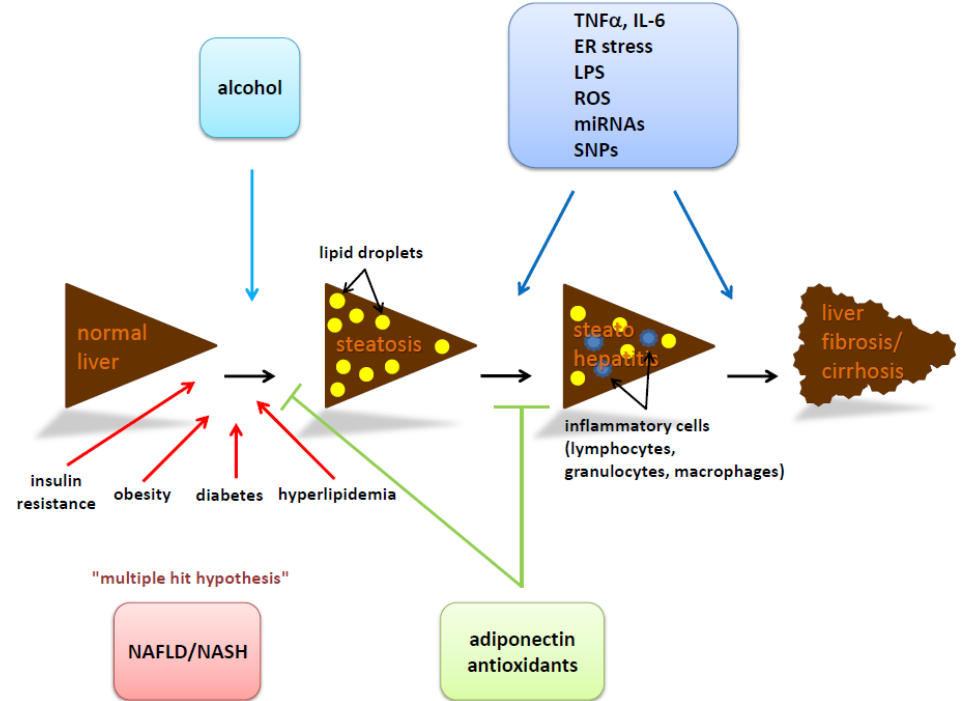
1. Schematic illustration of non-alcoholic fatty liver disease (NAFLD)/ non-alcoholic steatohepatitis (NASH) progression. A lifestyle with a balanced diet, moderate alcohol consumption and regular exercise supports the maintenance of an intact liver function. The intake of high energy food, less exercise and/or enhanced drinking of alcohol (light blue rectangle and arrow) leads to increased amounts of triglycerides (TG) in the liver which are stored as lipid droplets (yellow dots). Over time the degree of fatty change might reach an extent of hepatic steatosis. Concomitant effects like insulin resistance, obesity, type 2 diabetes mellitus (T2DM) and hyperlipidemia have a promoting effect (red arrows). It is under debate if the development of steatosis and NAFLD/NASH is the result of a “two” or “multiple hit event’’ (red rectangle). Adipocytokines, endoplasmic reticulum (ER) stress, endotoxins from gut bacteria, reactive oxygen species (ROS) and epigenetic modifications (dark blue rectangle and arrows) are potential mediators promoting the development from hepatic steatosis to steatohepatitis and liver fibrosis and/or cirrhosis. Under physiological conditions fatty acid metabolism is tightly controlled by antagonists such as adiponectin and antioxidants (green rectangle and arrows) which are involved in insulin tolerance, glucose consumption and fatty acid oxidation as well as in elimination of